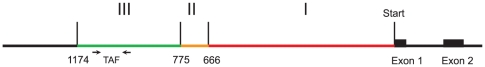
The upstream sequence of PgiC2, drawn to scale, with boundaries identified by sequence comparisons with other PgiC genes.The Transgene Associated Fragment (TAF) is marked, and the positions of the primers used for its amplification are shown. The results given in Table 1 are coded as follows: Red denotes sequence similarity with all types of PgiC-genes. Orange denotes similarity between PgiC2 and PgiC in P. palustris. Green denotes similarity between the two tested plants with PgiC2 with no similarity to any of the other plants.